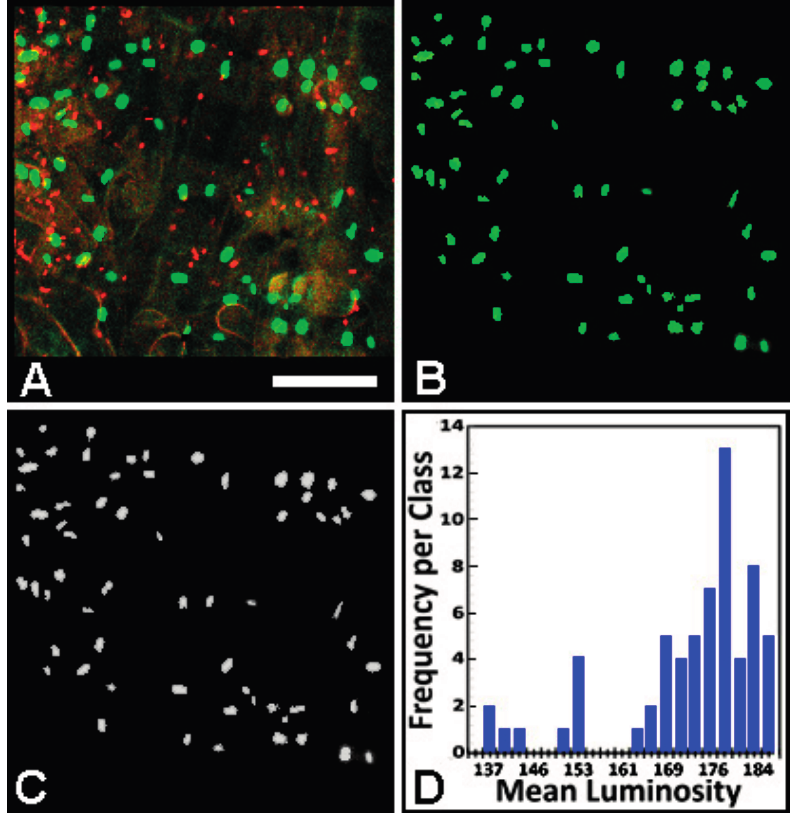
Figure 6. In situ variation in intensity of cell communication between Pseudomonas putida reporter cells colonized on a wheat rhizoplane. ( a ) Red-fluorescent “signal source” cells communicating with green-fluorescent “signal sensor” cells via secreted N -acylhomoserine lactones; ( b ) Green color-segmented and ( c ) grayscale converted images of the communication response in Figure 6a; and ( d ) Frequency distribution of the mean luminosity of Gfp fluorescence per sensor cell indicating the in situ variation in cell communication intensity at single-cell resolution. Bar scale is 15